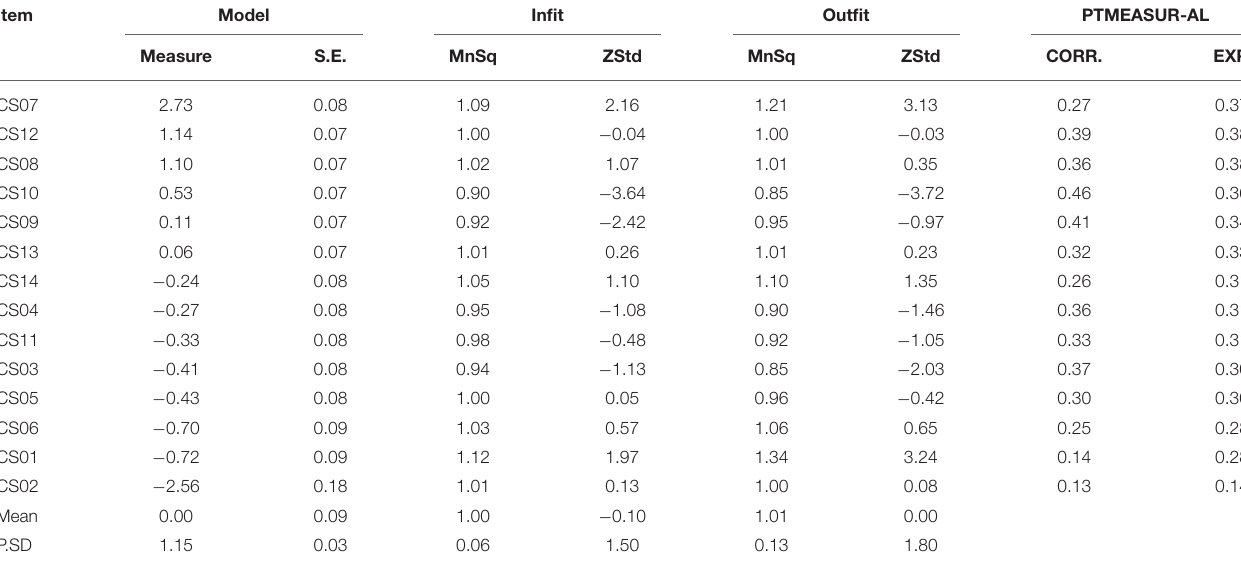
TABLE 3 | Item measure and fit statistics.